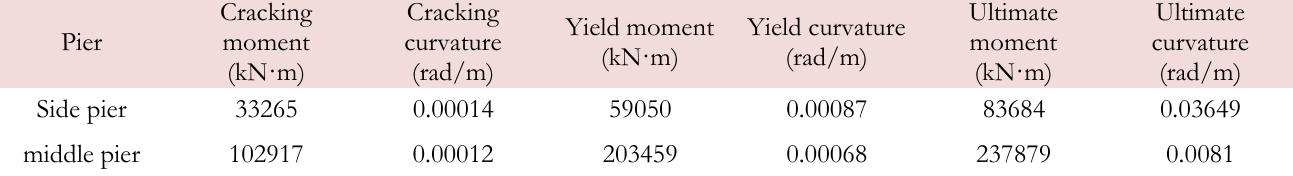
Table 1: Control points of the moment-curvature curve for the bottom section of bridge